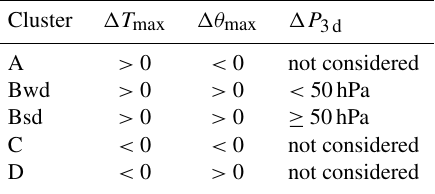
Table 2. Criteria for trajectory clusters following Zschenderlein et al. (2019) but with a different pressure